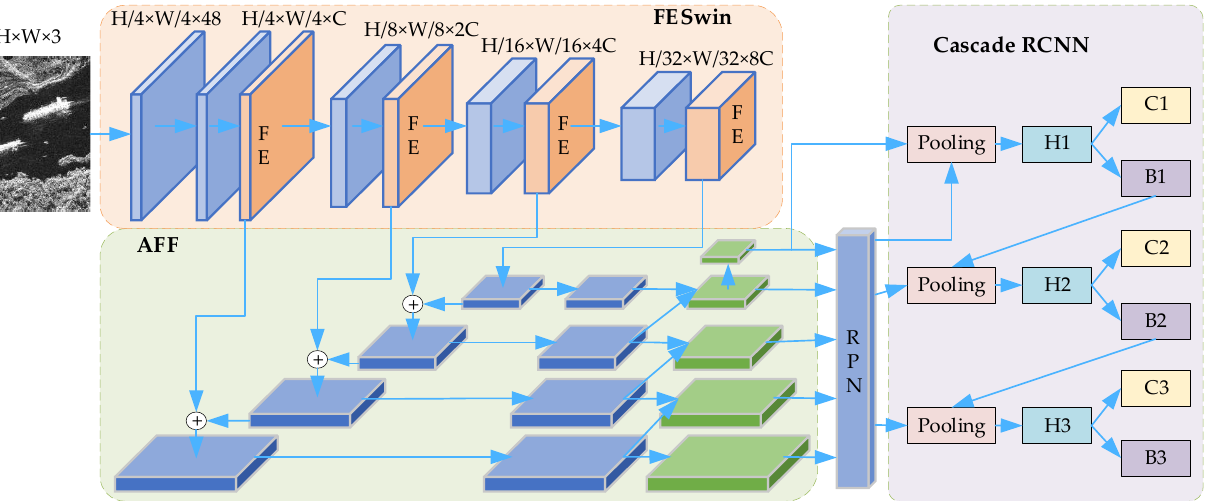
Figure 1. The overview of ESTDNet. Compared to Cascade R-CNN Swin, we mainly improve the feature extraction capability by using FESwin as the backbone network and employing AFF to replace the original FPN for feature fusion.